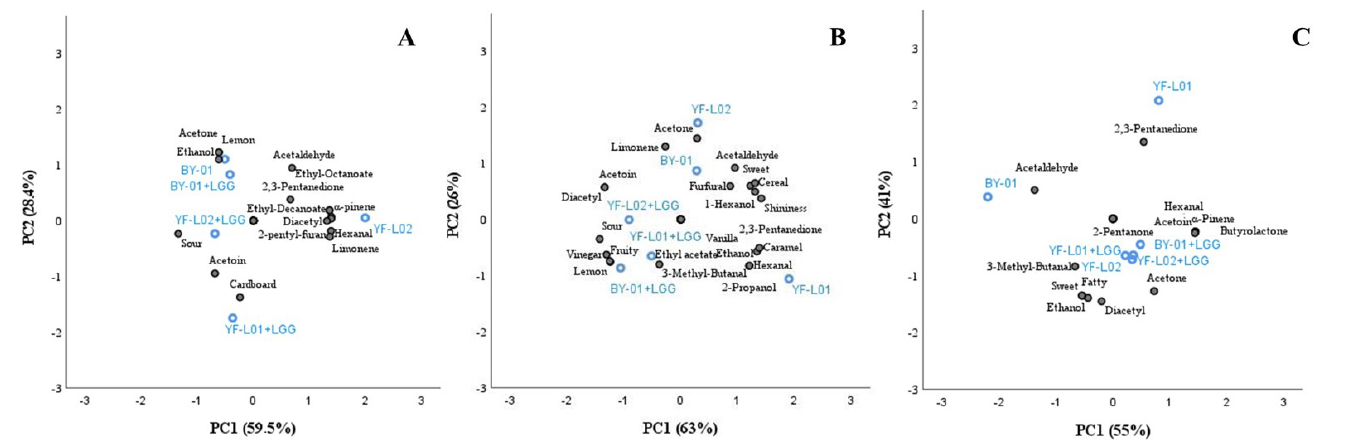
Figure 6. Effect of different culture combinations and the volatile organic compounds they produced on the sensory perception of flavor attributes. PCA bi-plot of the first two principal components (PCs) in fermented ( A ) soy, ( B ) oat, and ( C ) coconut samples labeled by culture